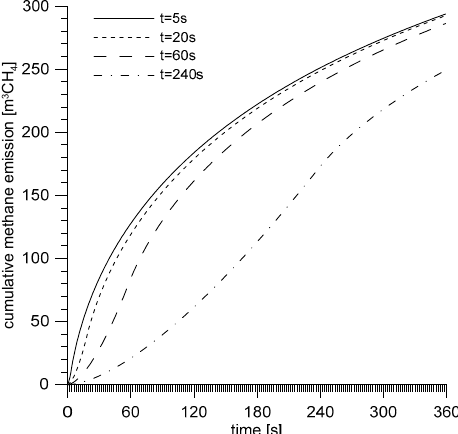
Figure 15. Model cumulative methane emissions determined based on a sphere during the Zofiówka outburst.